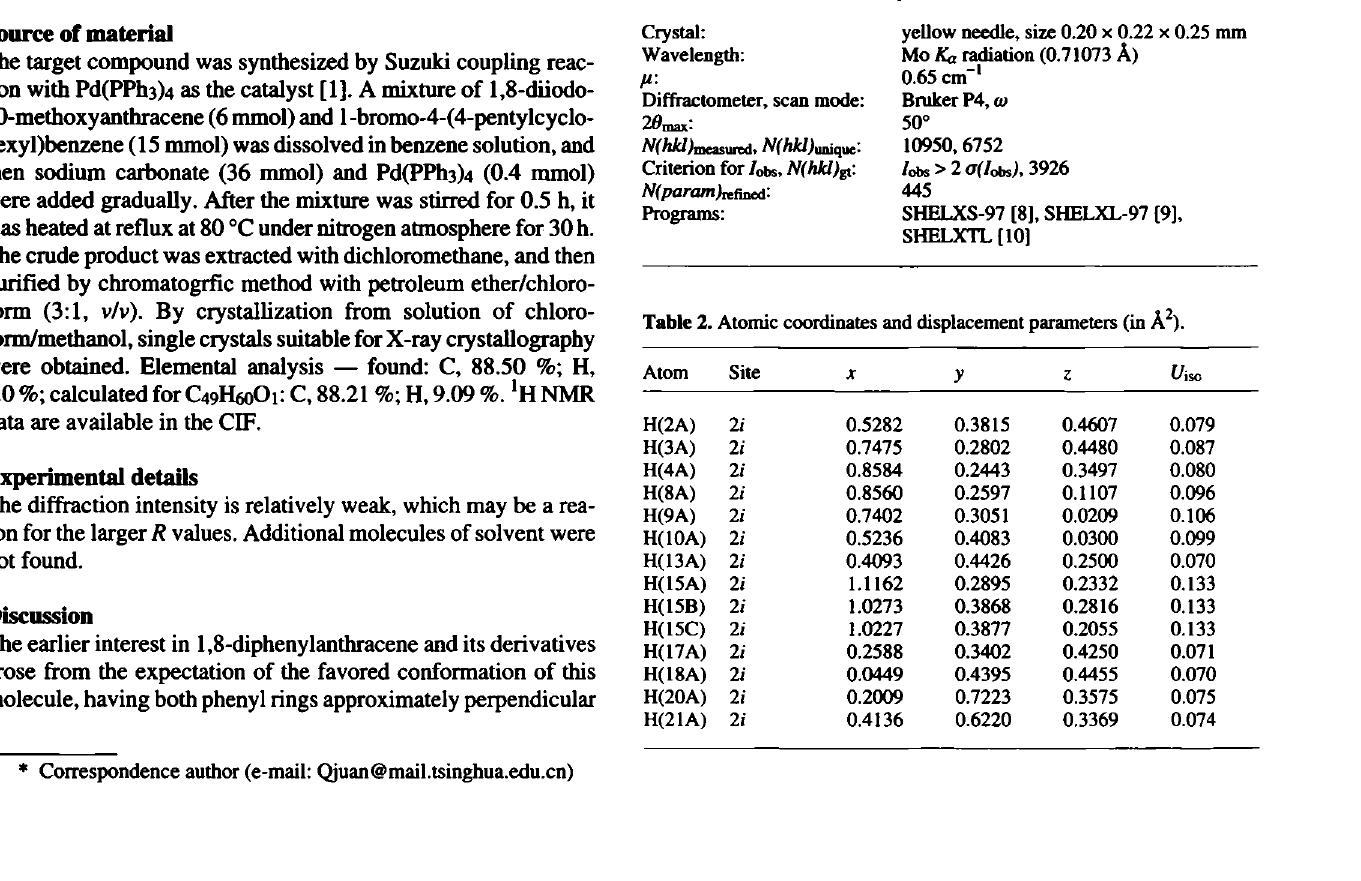
Table 1. Data collection and handling.